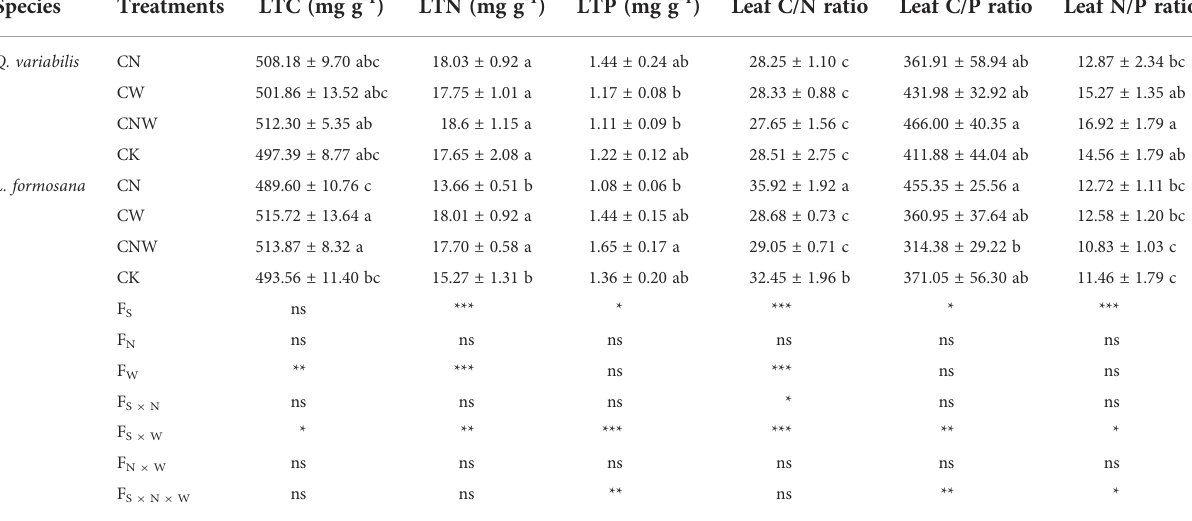
TABLE 1 Changes in leaf C, N, and P content and C:N:P stoichiometry of Q. variabilis and L. formosana under canopy N application and water addition conditions.